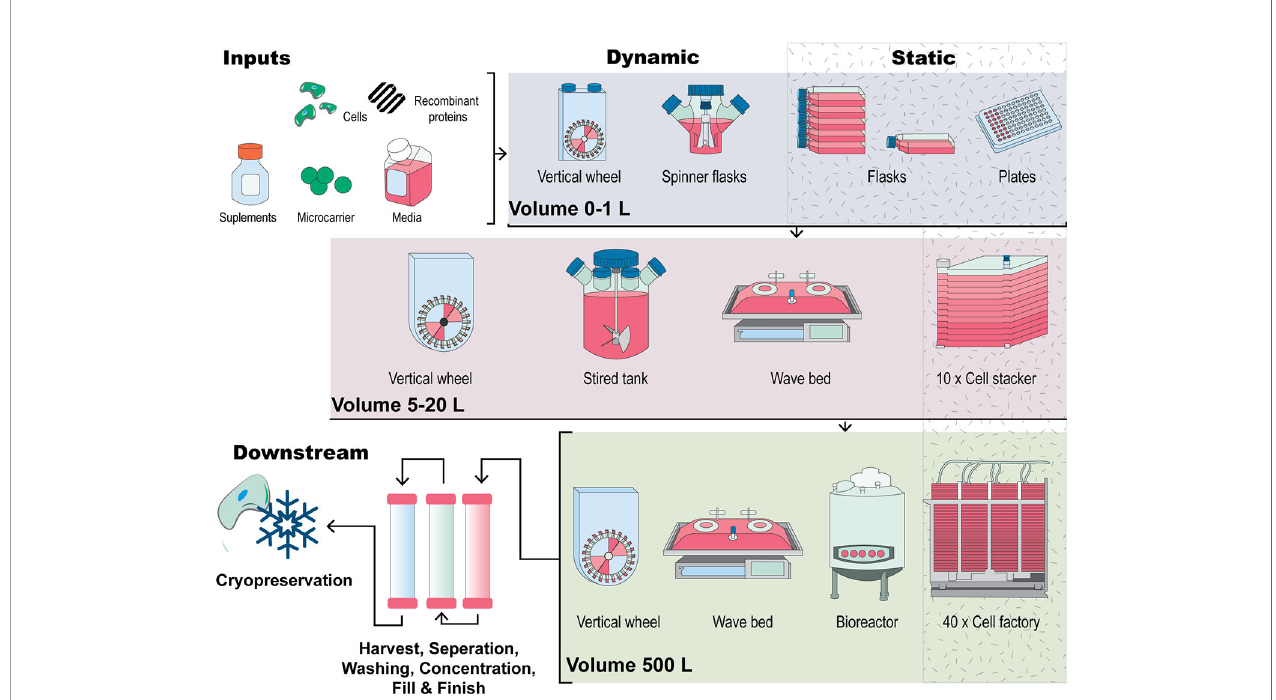
FIGURE 2 | A visual comparison of expansion strategies for human MSCs. Inputs to the process include cells, media, supplements, a culture surface ( fl ask, cell stacker, microcarriers) and other additives including growth factors. Figure adapted from (Kropp et al., 2017). Traditional culturing methods encompass 2D, planar technologies such as expanding MSCs in a culture dish or fl ask by continual passaging. Scale out of this approach uses cell stackers or multilayered fl asks which work in this manner through multiplication of the culturing fl ask. In comparison, scale-up manufacturing methods involve MSCs forming aggregates or being seeded onto microcarrier in suspension in bioreactor systems such as stirred tank, vertical wheel or wave bag bioreactors. Downstream processes such as cell harvesting cell washing, cell concentration, fi nish and fi ll and storage through cryopreservation are also critical parts of the manufacture of MSCs for clinical